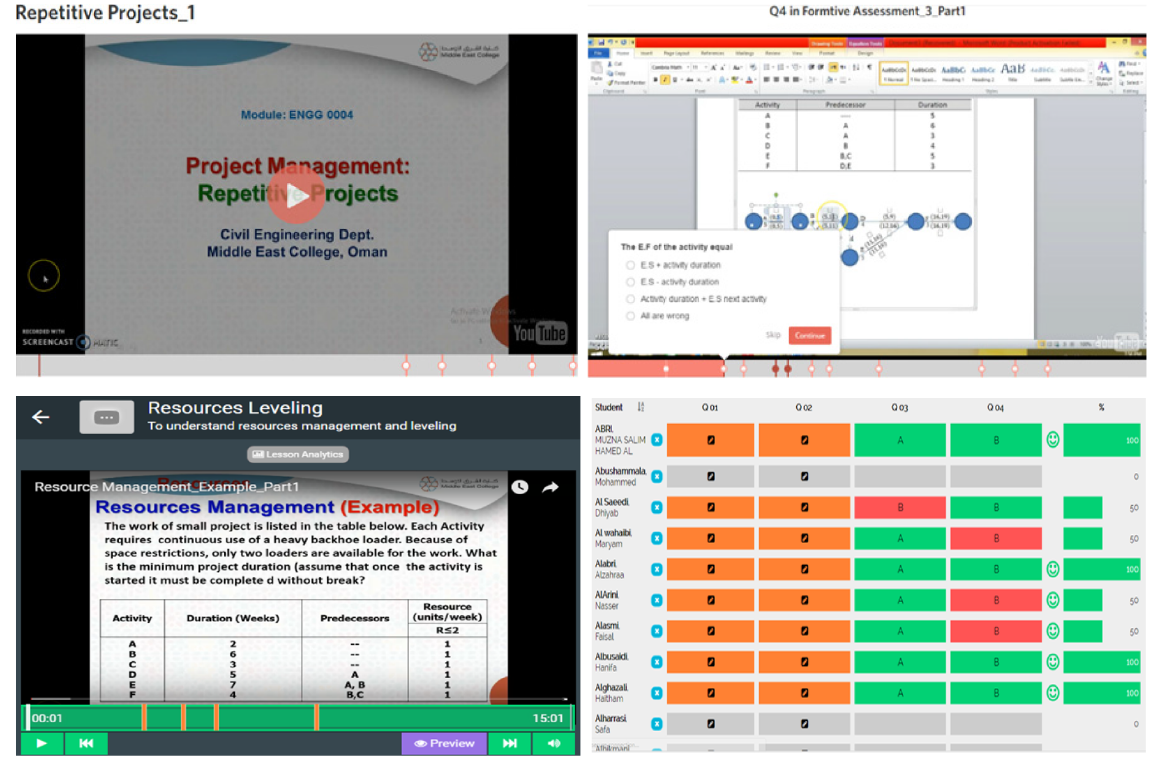
Figure 1. Out-class videos using Vizia and PlayPosit interactive